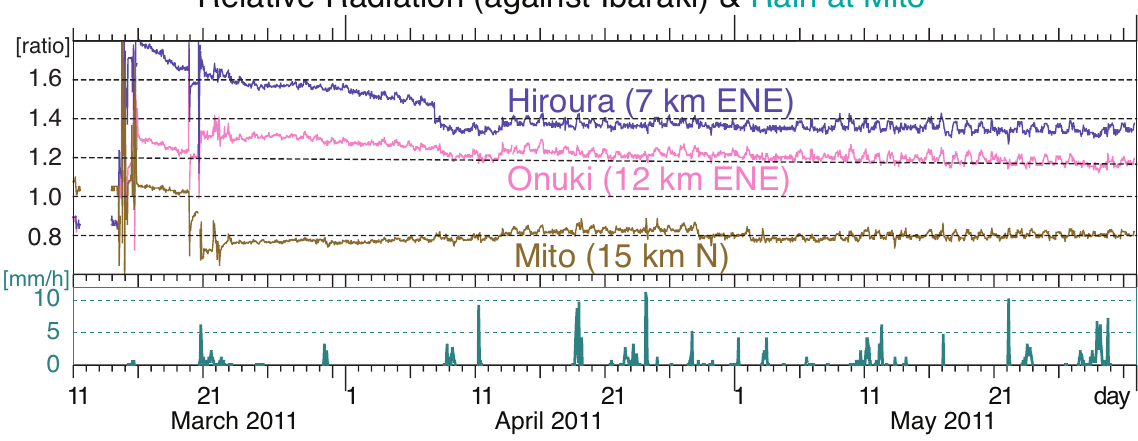
Fig. 5. Top panel: Relative values of the radiation dose rate at three stations near Ibaraki-cho over the value at Ibaraki-cho during March– May 2001. The east-northeast (ENE) direction is toward the sea (cf. Fig. 2), whereas north (N) direction is toward the nuclear plant (FNPP). Bottom panel: rainfall at Mito. Both data are hourly